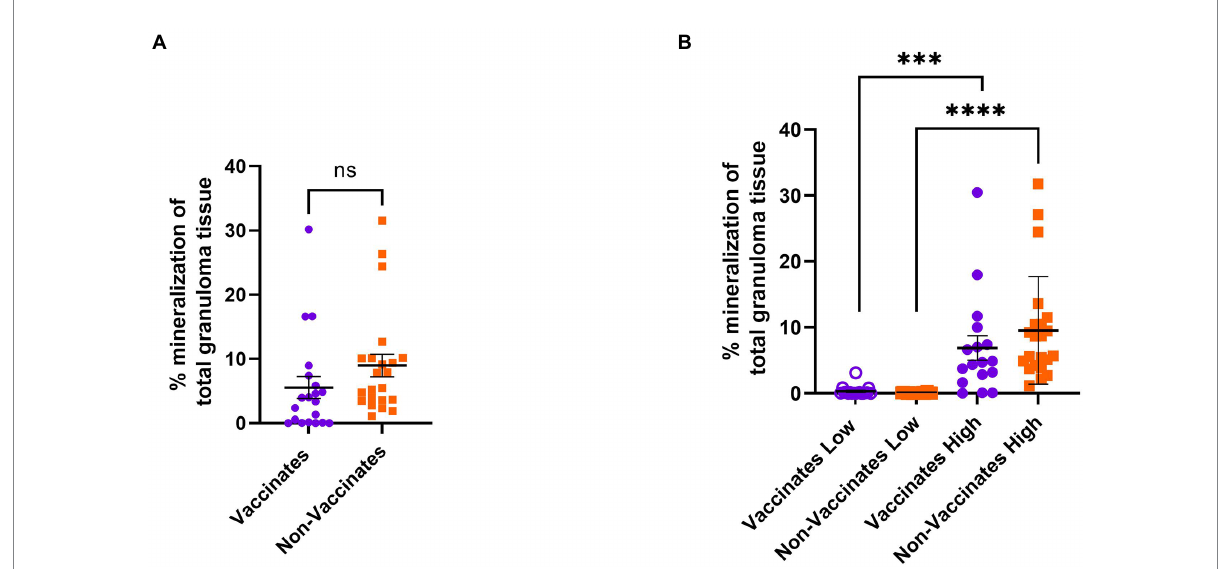
FIGURE 7 Percentage of granuloma area comprised of mineralization as measured using Von Kossa staining in BCG-vaccinated and non-vaccinated cattle infected with M. bovis. Values are broken down by vaccination group (A) and by vaccination group and grade (B) . Each dot represents one animal and its mediastinal and tracheobronchial lymph nodes. Values are presented as means ± SEM. (*** = p value 0.0009, **** = p value <0.0001, ns = not